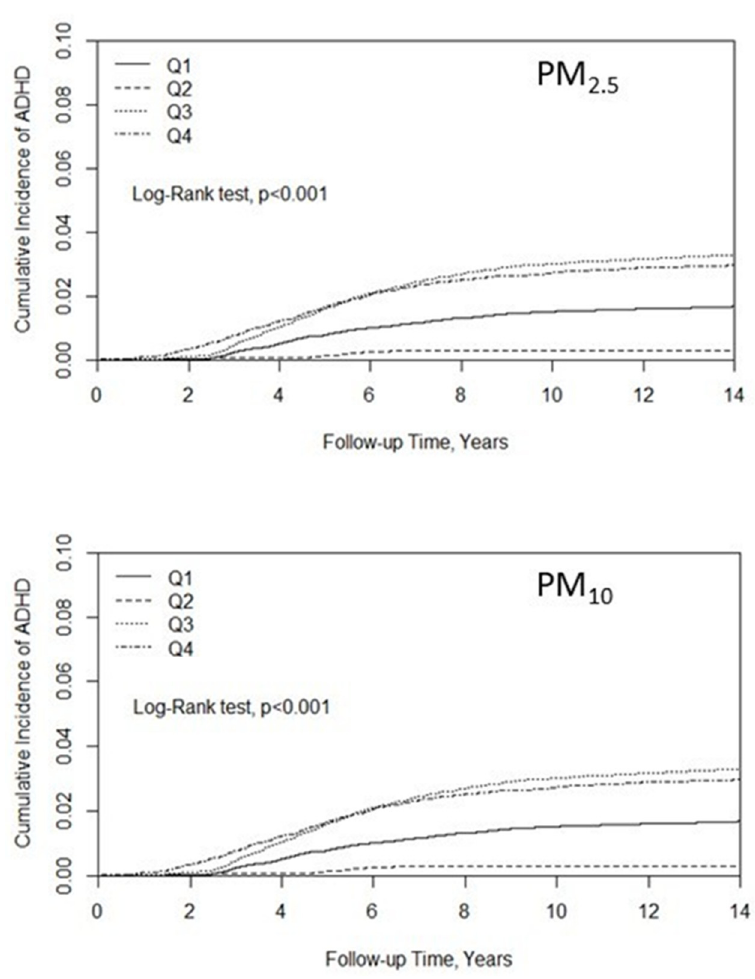
Figure 1. Kaplan–Meier curves of the accumulative incidence rate of ADHD during the follow-up period among the different quartiles for each air pollutant. Table 3. The risk of ADHD in children exposed to PM 2.5 /PM 10 stratified by quartile of daily average concentration using the Cox proportional hazard